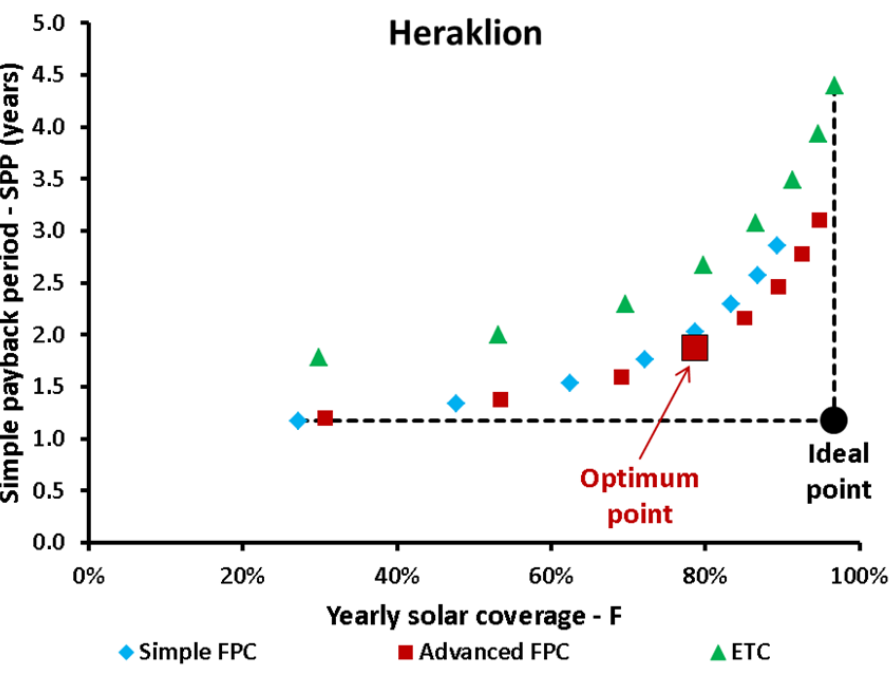
Figure 28. Multi-objective optimization for the Heraklion city — Zone A.